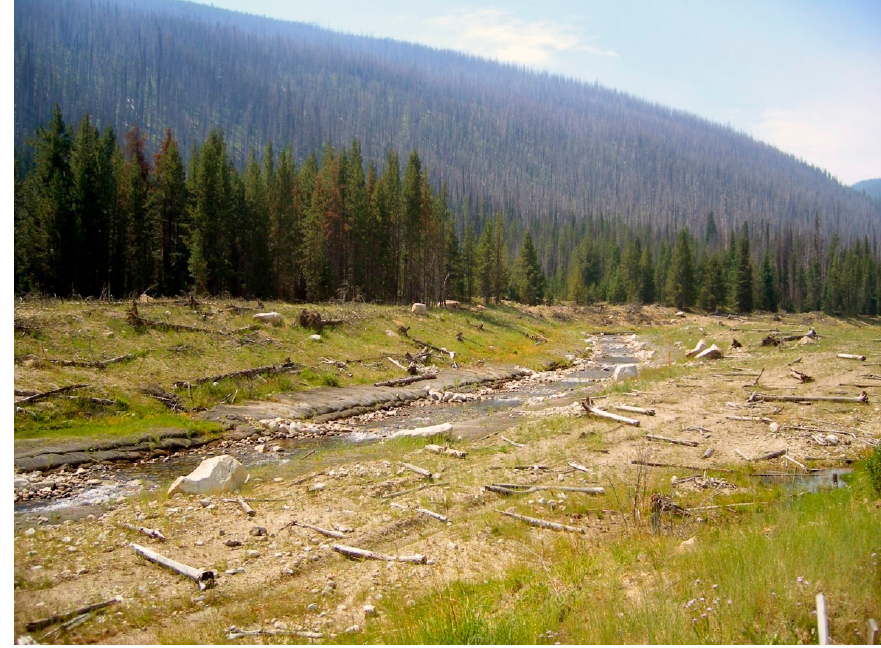
Figure A1. HH-reach in summer 2007. Photo by David Pilliod.